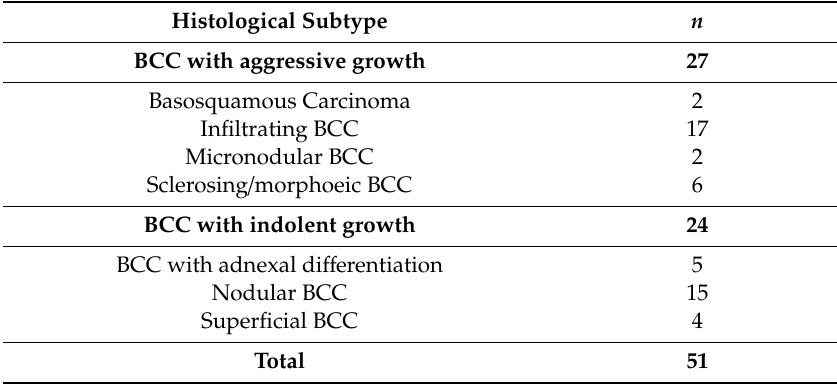
Table 1. Histological diagnosis of samples included in the